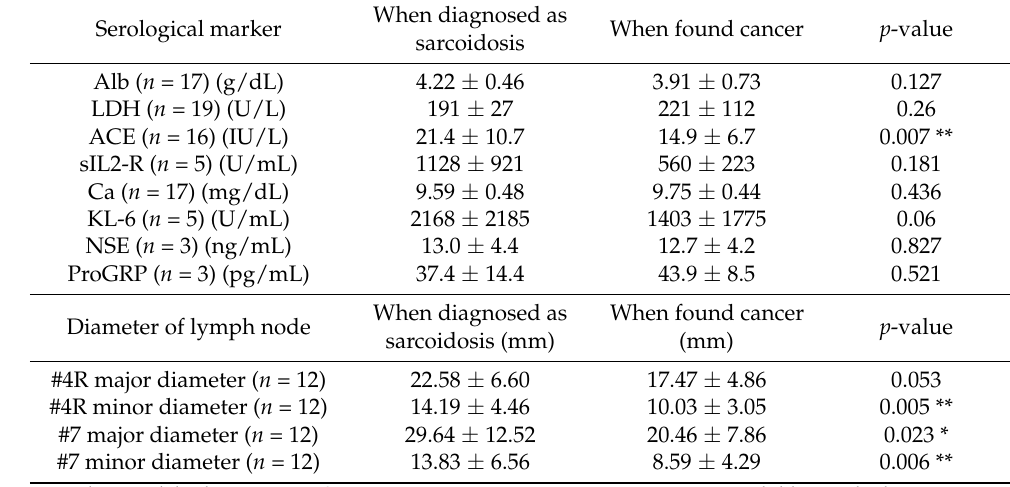
Table 3. Comparison of serological data and mediastinal lymph node size in patients with tumor development following sarcoidosis at the time between the onset of sarcoidosis and the subsequent diagnosis of malignancy.